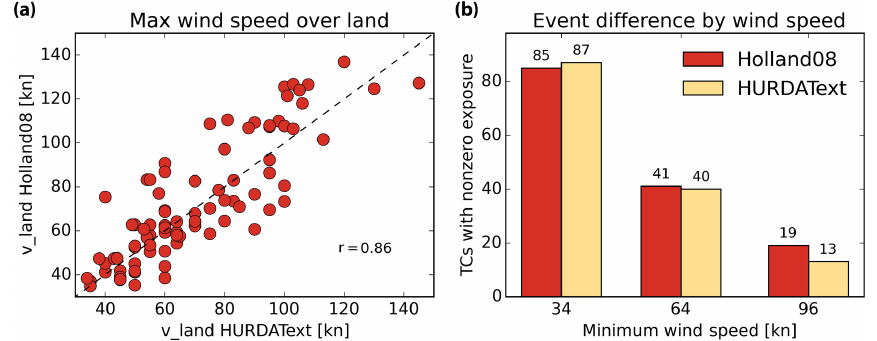
Figure 4. Comparison of wind speed at landfall by event (a) and the aggregated number of TCs with nonzero exposure for different wind speed thresholds (b) between 1988 and 2012 using estimates based on the Holland08 wind field model and the observed HURDAText